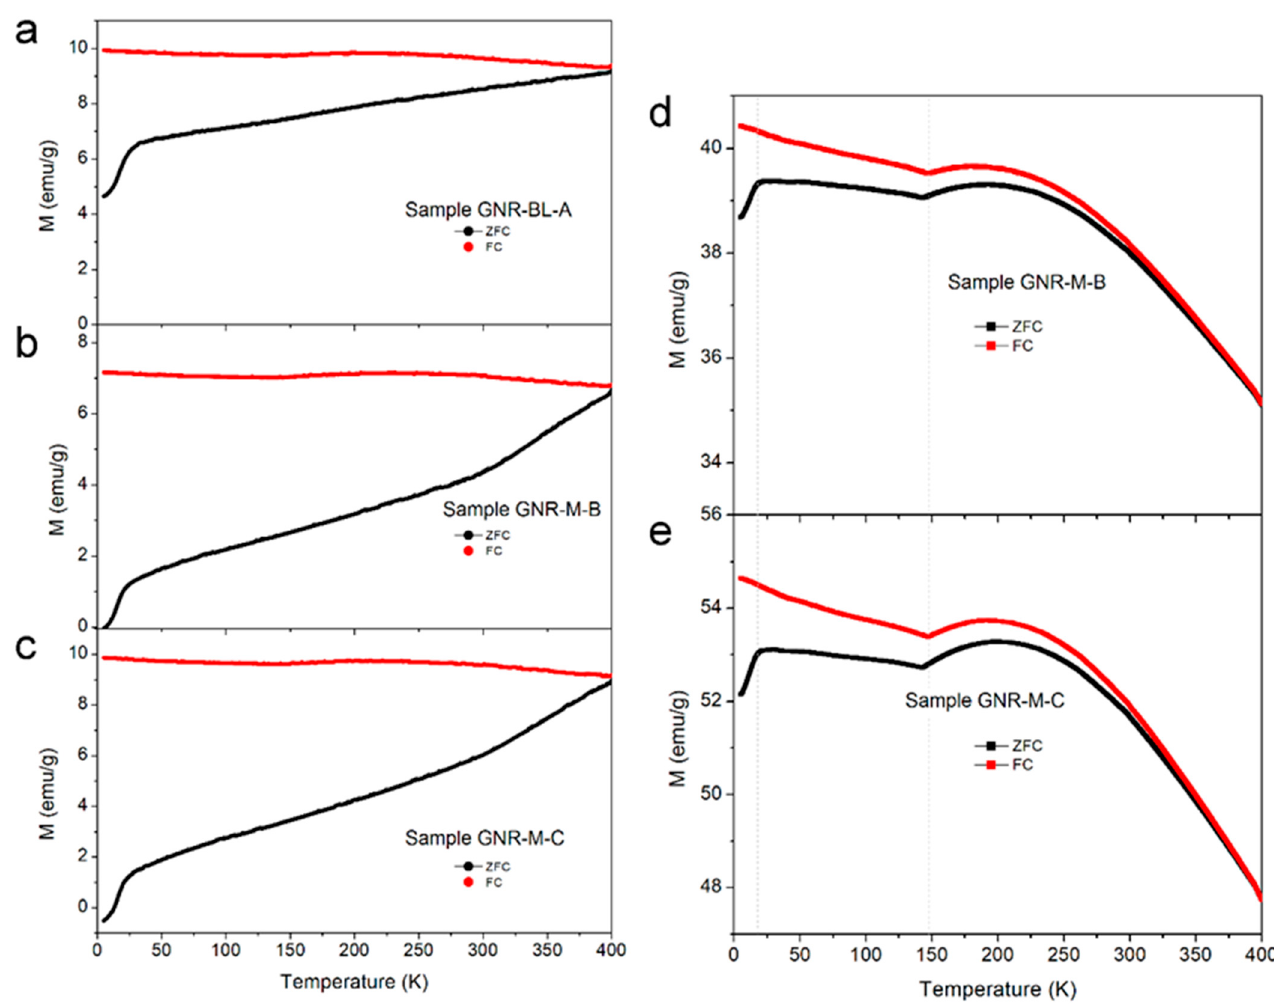
Figure 8. Zero-field-cooling (ZFC) and field-cooling (FC) magnetization curves as a function of temperature obtained from the black and magnetic solid phases of long-term enrichment cultures. Black line, ZFC; red line, FC. ( a – c ) Left panel showing ZFC and FC curves obtained at 100 Oe. ( d , e ) Right panel showing ZFC and FC curves at 1 kOe. Note transitions at ~30 K ( a - e ) and ~150 K ( d , e ) and the distinct regimens below and above 150 K at 1 kOe ( d , e ). ( a ) GNR-BL-A, ( b , d ) GNR-M-B, and ( c , e ) GNR-M-C. See Table 1 for more details on these samples.